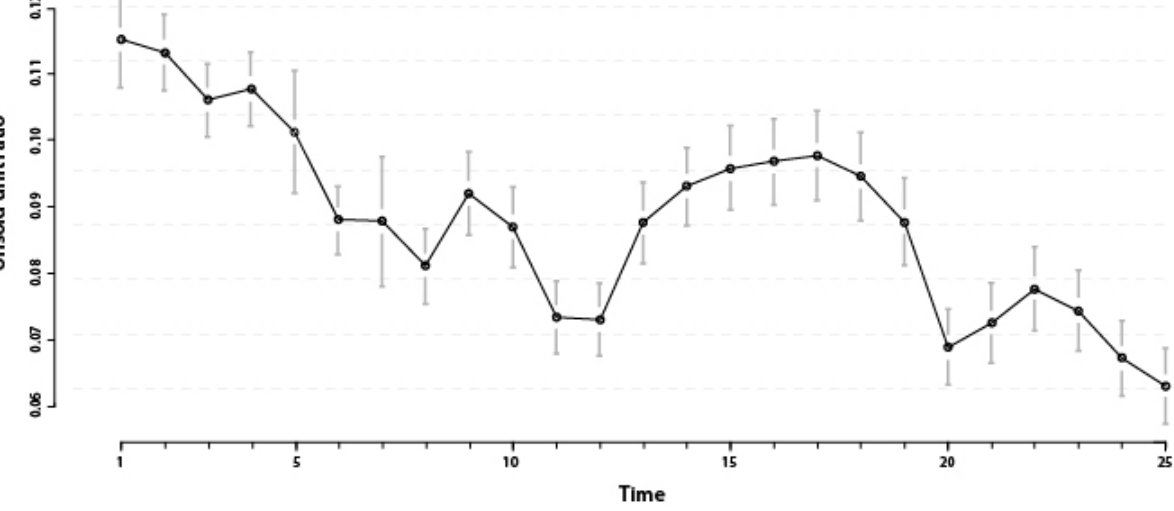
Figure 4. Observed growth in the mean ratio of total unsold units by time.